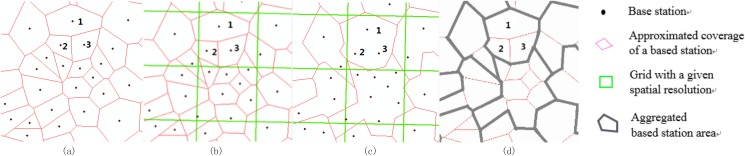
Privacy protection method for mobile phone location dataset by aggregating base stations.(a) Original base stations. (b) Grid creation. (c) Base station aggregation. (d) Aggregation results.